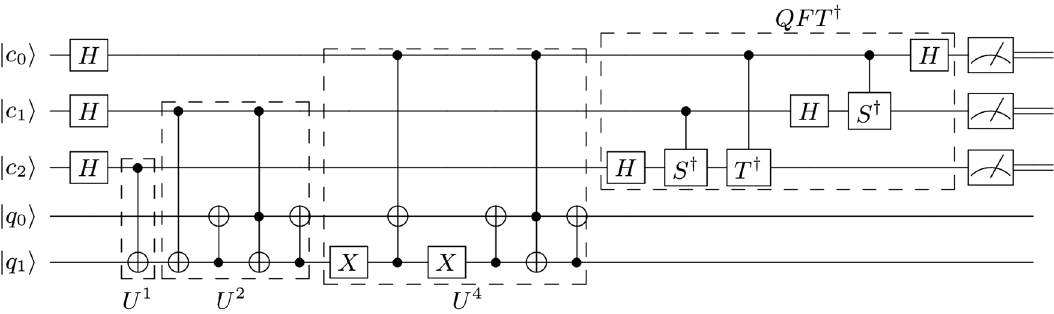
21 and a 4 . This circuit uses five qubits in total; = = R z ( π 2 ) and T R z ( π 4 ) are phase and π/ 8 = =